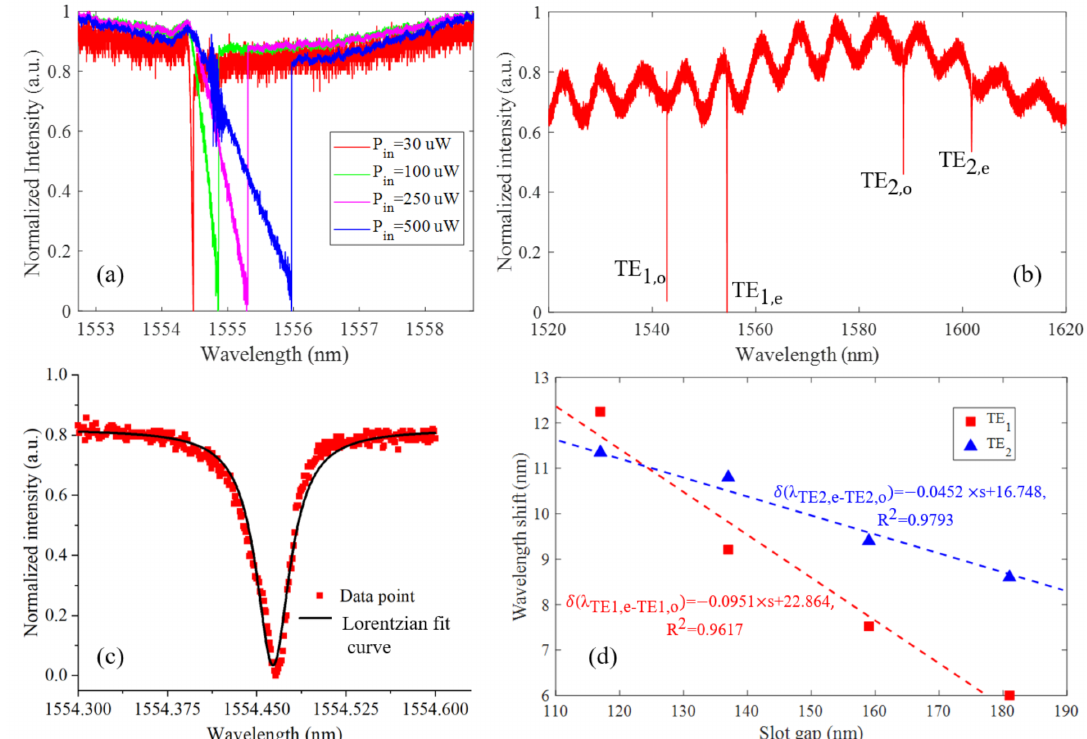
Figure 5. Optical characterization of the coupled PCN cavities. ( a ) Nonlinear transmission response under different pump light power; ( b ) transmission spectrum of the coupled PCN cavity; ( c ) resonance dip at the TE1,e mode with Lorentzian fitting; ( d ) resonant wavelength difference shift varying with slot